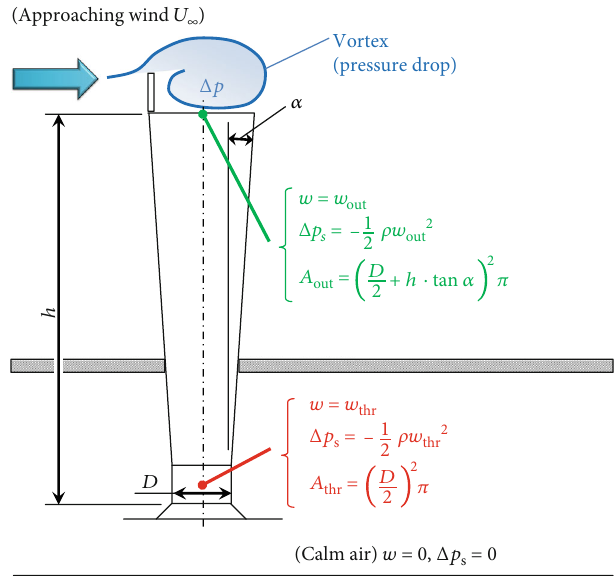
Figure 9: The schematic of the phenomenon around the WST.